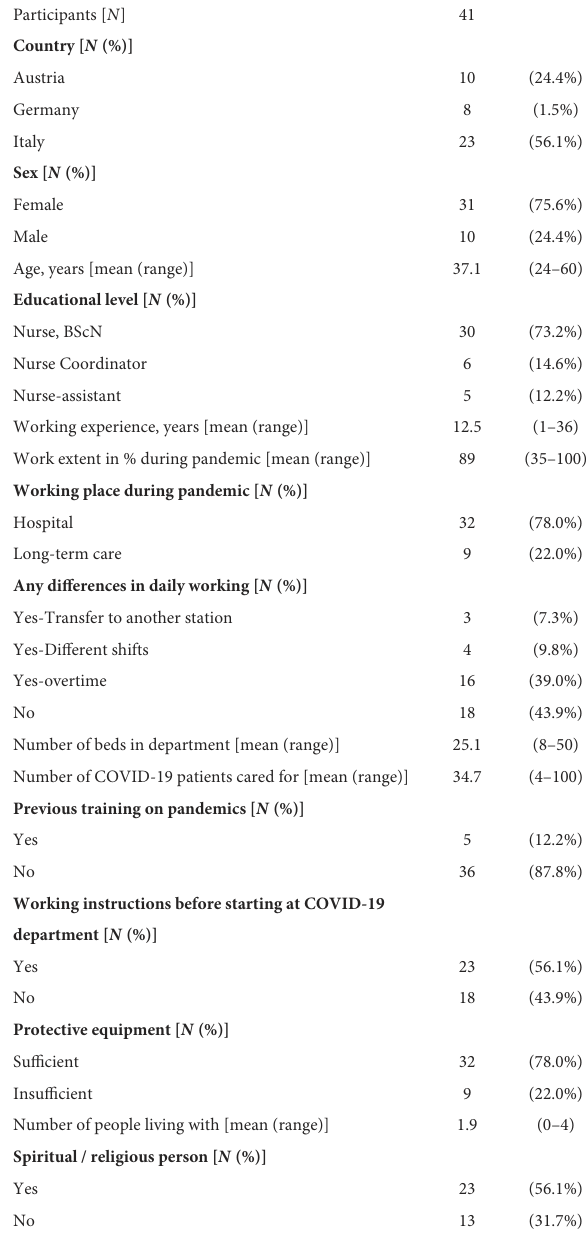
TABLE 1 Questions from the interview guide. TABLE 2 Participants